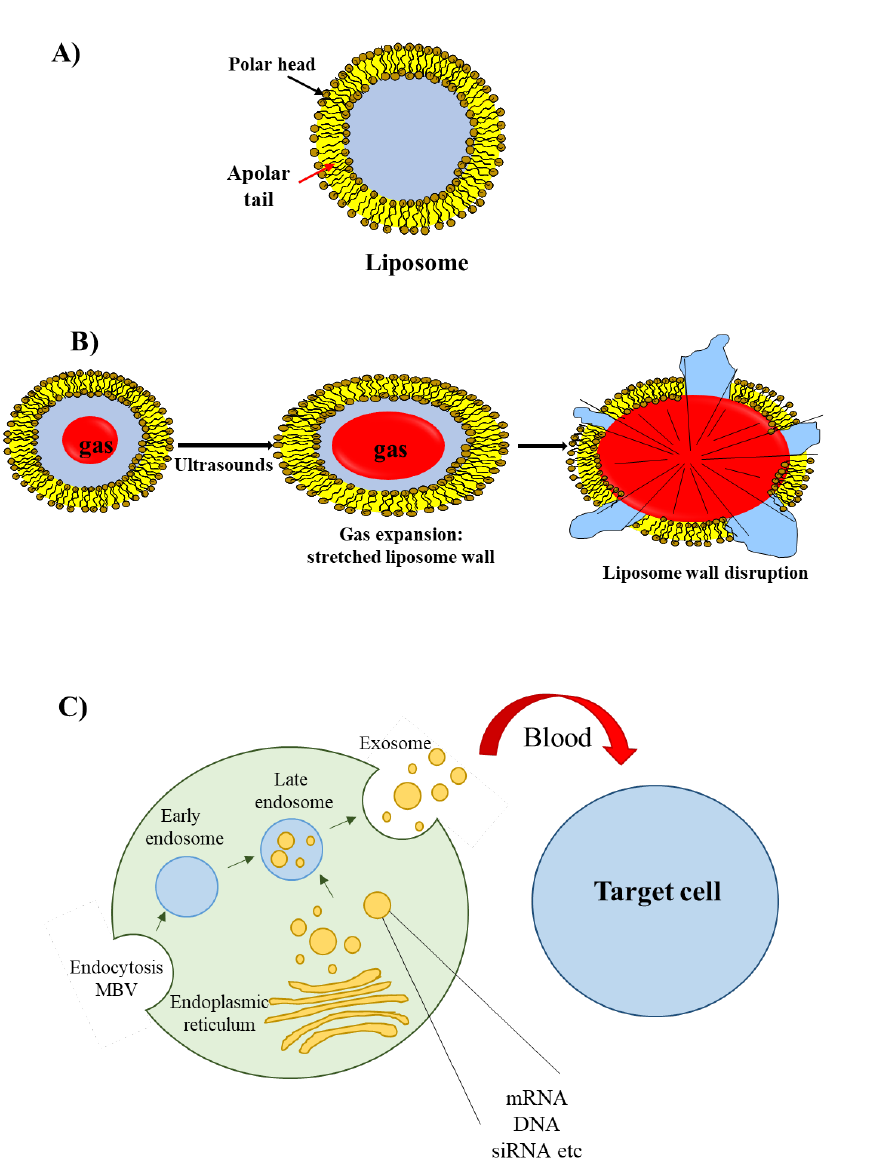
Figure 3. Liposomes, echogenic liposomes and exosomes. ( A ) The liposome wall consists of a double layer of amphiphilic lipids containing a polar head (oriented either towards the external or internal environments) and a polar tail (oriented towards the lipophilic region of the membrane). ( B ) Echogenic liposomes contain an inner gas phase that, in the presence of ultrasounds, undergoes expansion, contraction and vibration (cavitation); this phenomenon eventually determines liposome wall stretching and rupture. ( C ) Exosomes originate from early and late endosomes, which derive from invagination of the limited multi-vesicular body membrane (MBV); during this process, cellular proteins, mRNA, miRNA and DNA fragment are incorporated within the exosome; following exo- some delivery form the mother cell, cellular proteins/mRNA/miRNA/DNA fragment are released to recipient